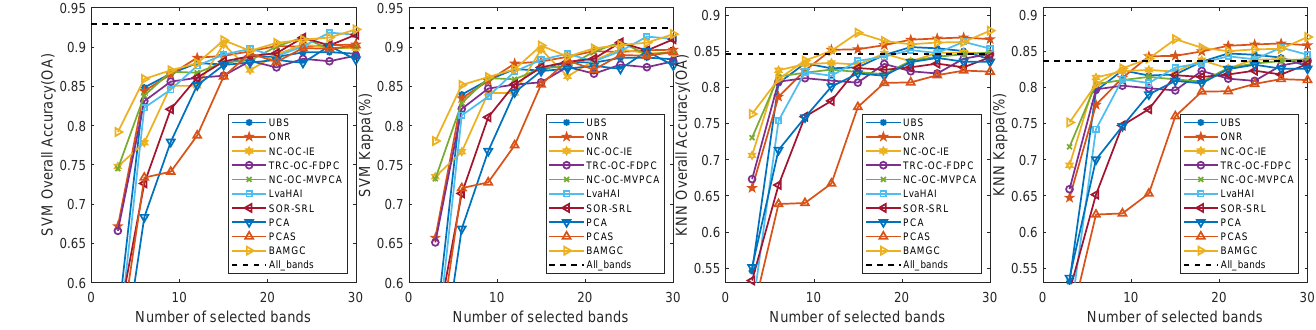
Figure 8. The comparison of OA and κ produced by SVM and KNN on the Botswana